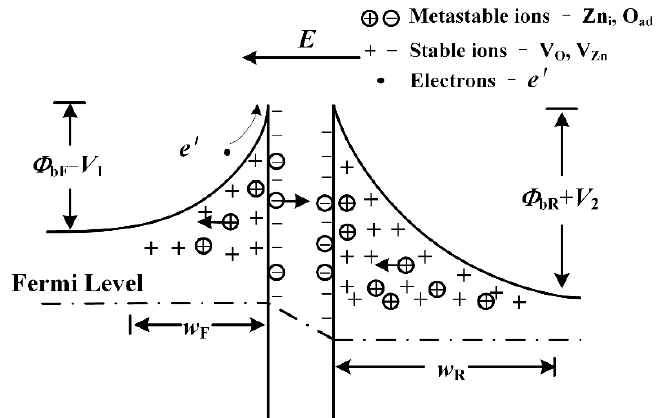
Figure 7. The schematic for ion migration based on the double Schottky barrier model.